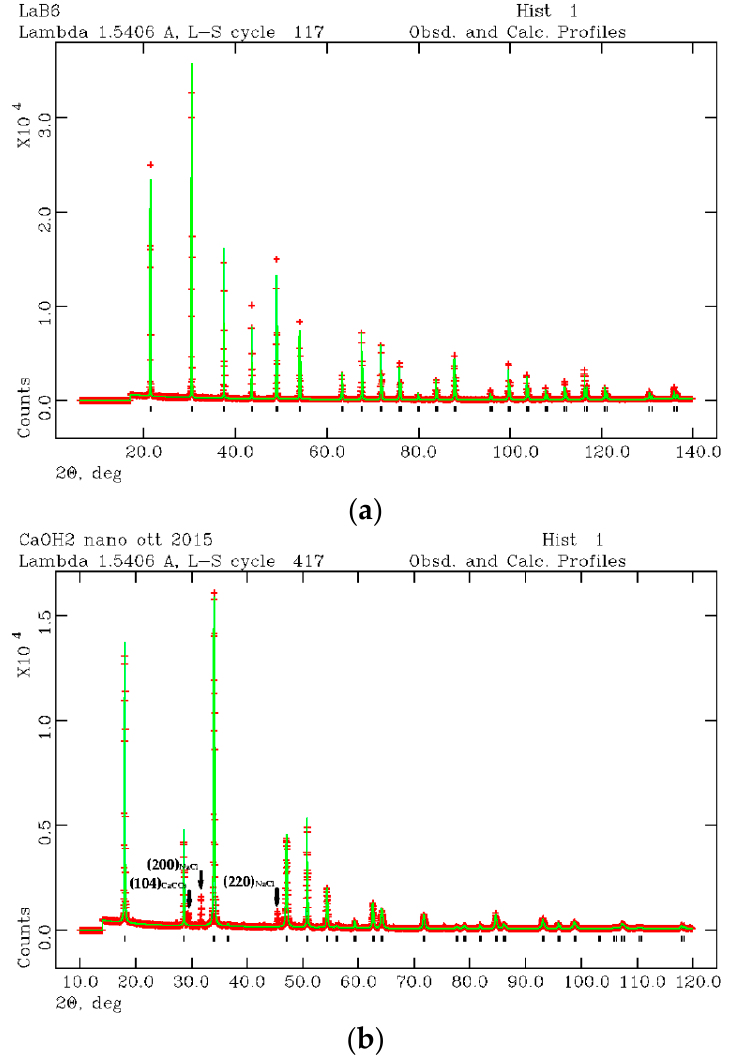
Figure 2. XRPD refined profiles of LaB 6 ( a ) and nano-Ca(OH) 2 ( b ) for microstructural analysis of the synthesized nano-Ca(OH) 2 .